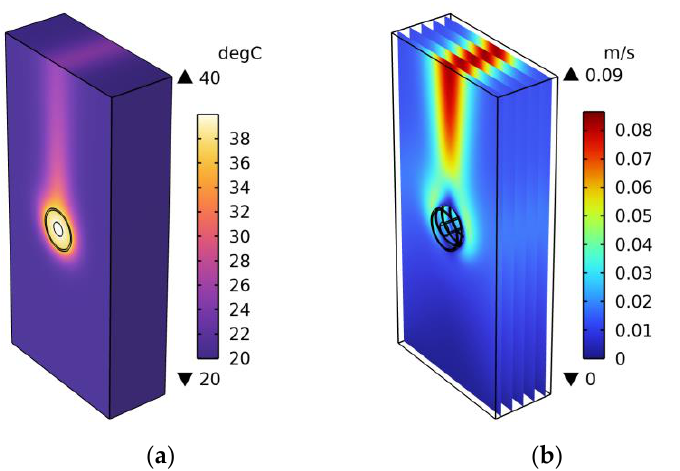
Figure 5. Distributions of ( a ) the thermal field and ( b ) the flow field when transmitting a 100 W electromagnetic wave at 1 GHz.